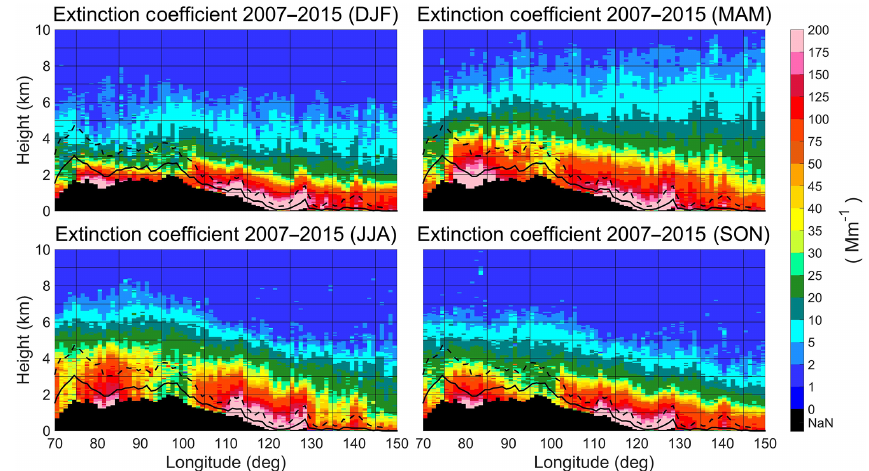
Figure 6. Vertical distribution of the climatological extinction coefficient profiles at 532nm over the area 35–45 ◦ N, 70–150 ◦ E, including the Taklamakan Desert and the Beijing–Tianjin–Hebei area, derived from 9 years of CALIOP measurements (2007–2015): winter (DJF), spring (MAM), summer (JJA) and autumn (SON). The solid and broken lines indicate the mean and maximum elevation of the aerosol extinction above the